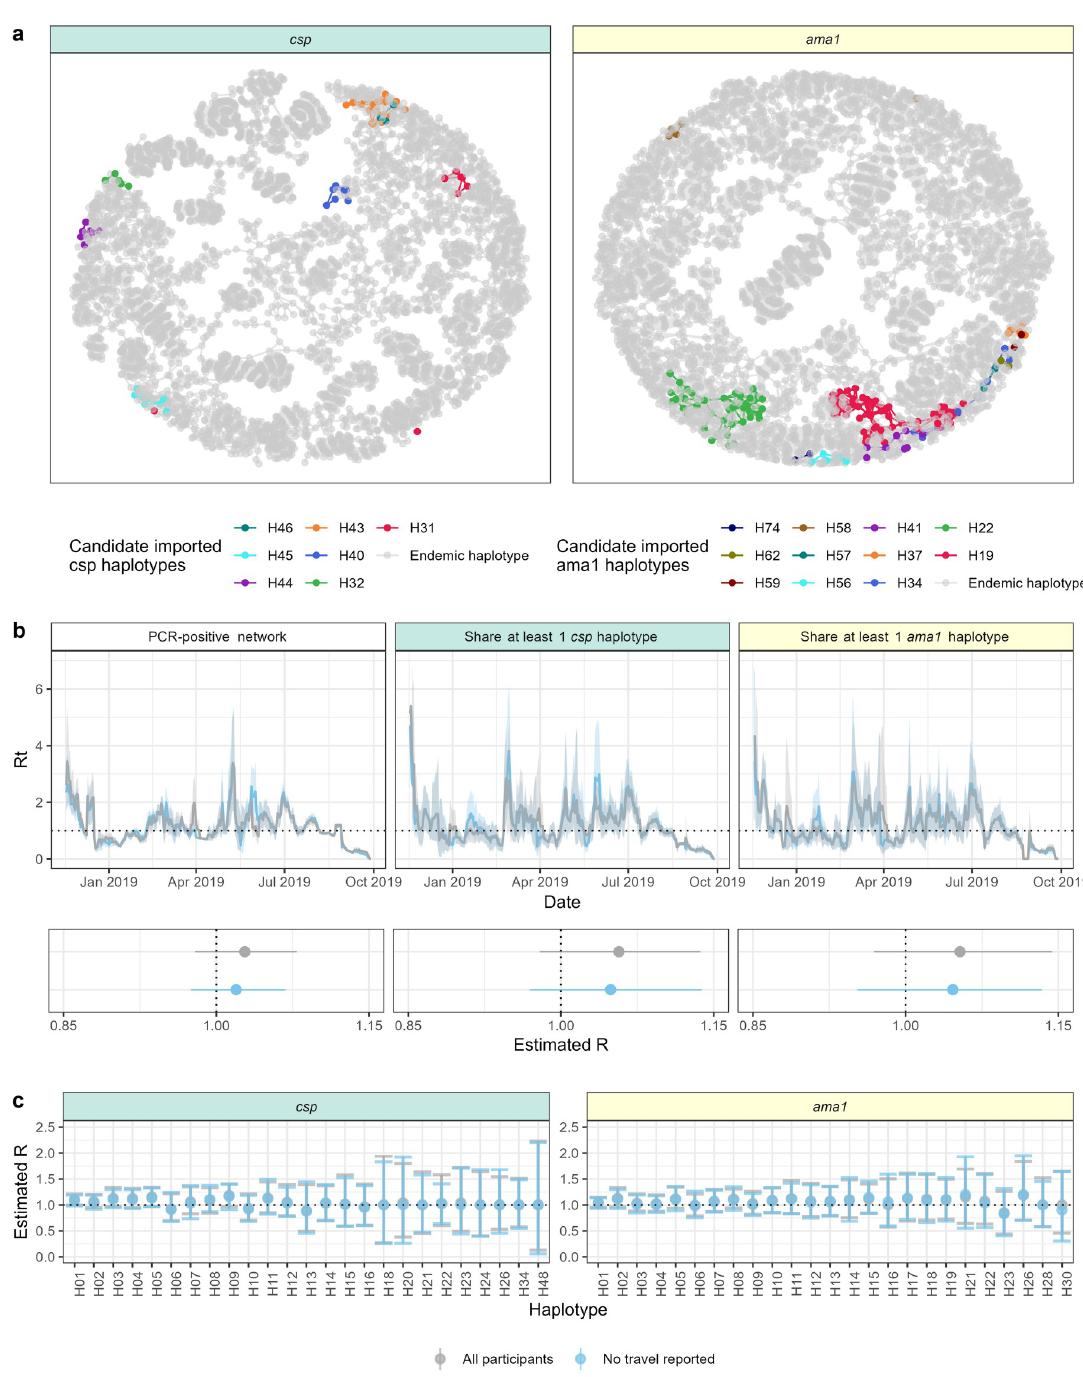
Fig 5. Contribution of travel to local transmission networks. (a) Transmission nodes (points) and edges (lines) for individual csp and ama1 haplotypes. Colors represent transmission attributable to candidate imported haplotypes. Edges drawn only if the relative transmission likelihood (Eq 4 in methods) was > 0.02. (b) Top: Weekly estimates of the P . falciparum reproductive number (Rt) for transmission networks composed of (left) PCR-positive individuals, (middle) participants sharing � 1 csp haplotype, and (right) participants sharing � 1 ama1 haplotype. Lines indicate population with (gray) or without (blue) participants reporting travel. Bottom: Overall estimates of P . falciparum reproductive number in each population both with (gray) and without (blue) the participants reporting travel. Dots indicate point estimate and bars the 95% confidence interval. (c) Haplotype-specific estimates of R for P . falciparum transmission networks with (gray) and without (blue) individuals reporting travel for (left) csp and (right) ama1 . Dots indicate point estimate and bars the 95% confidence interval.